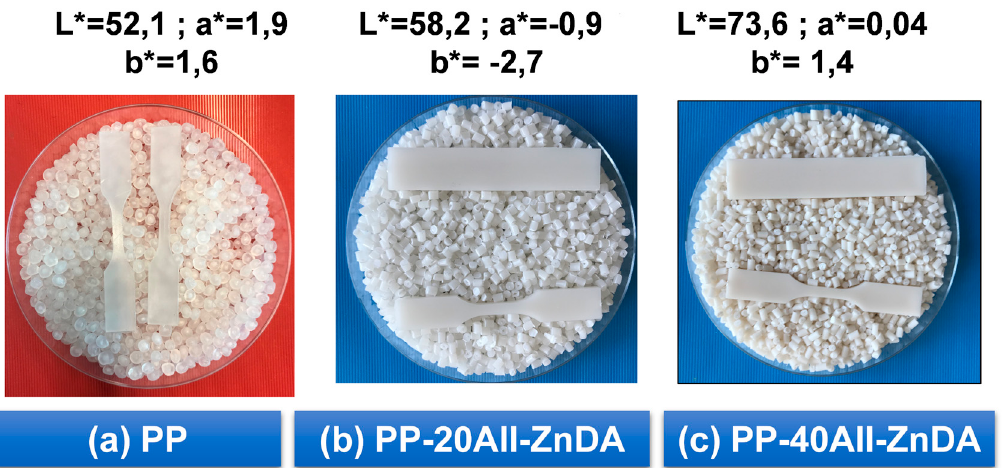
Figure 12. ( a – c ) Images of PP and PP–AII–ZnDA composites as granules and as specimens obtained by IM, together with the results of color measurements (CIELab): ( a ) neat PP is translucent, whereas the IM specimens show some warpage; ( b , c ) PP–AII–ZnDA composites showing high whiteness and good surface quality for IM specimens.